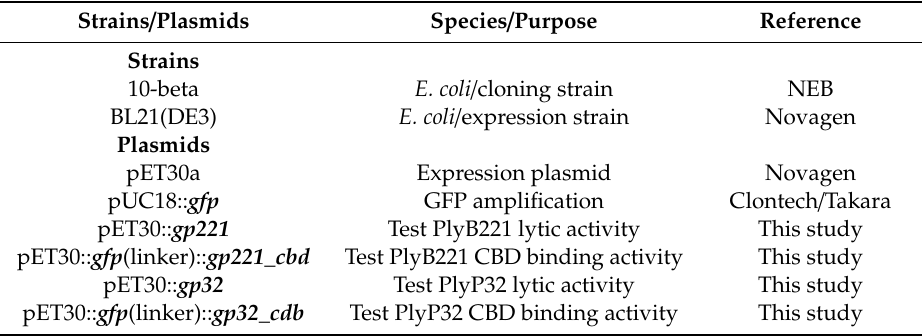
Table 1. Strains and plasmids used for cloning and expression experiments.